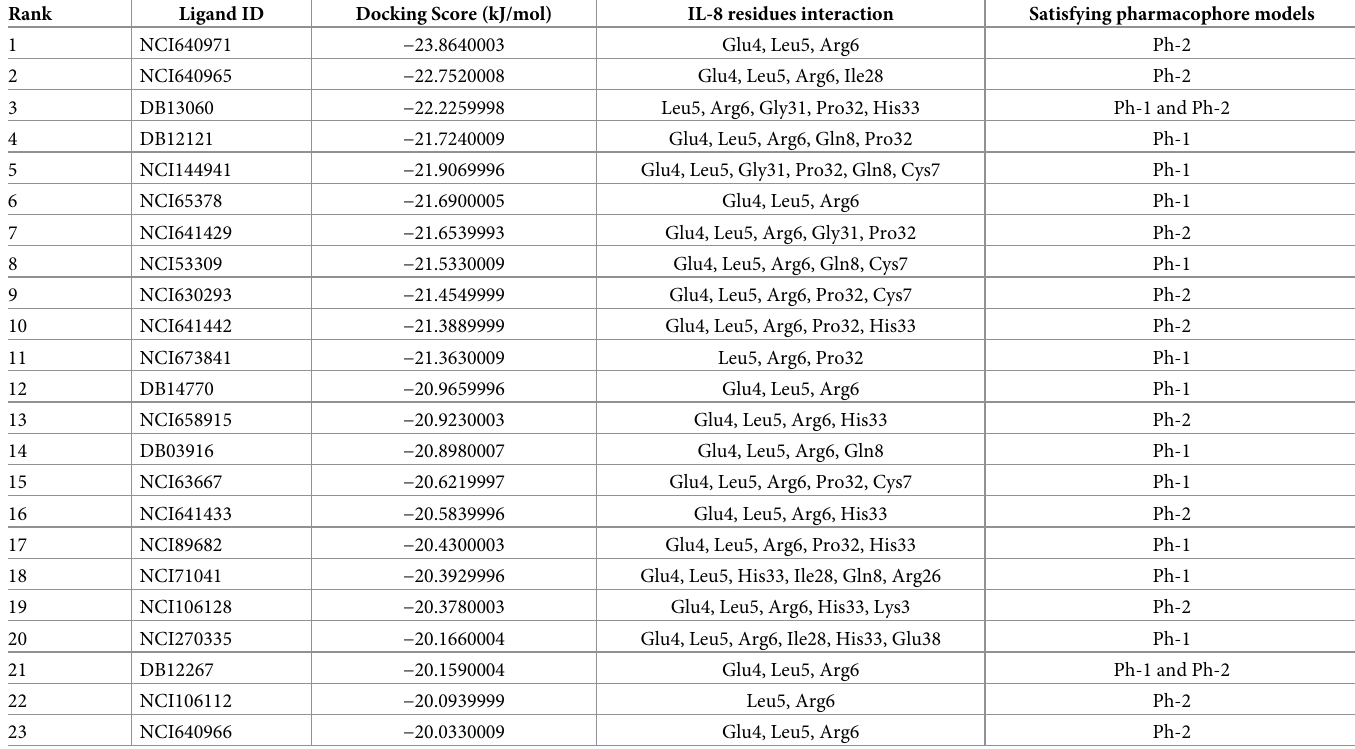
Table 2. Studied ligands with docking scores smaller than −